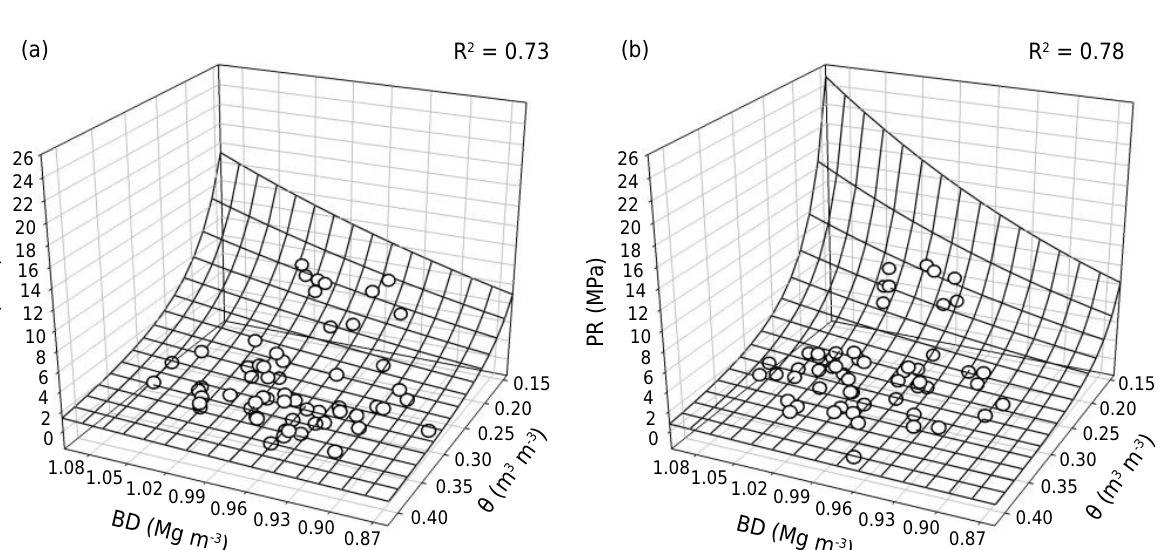
Figure 3. Response surface of soil penetration resistance (PR) as a function of bulk density (BD) and moisture (θ) estimated by the model fit PR = a × BD b × θ c . Surface liming (a) and incorporated liming